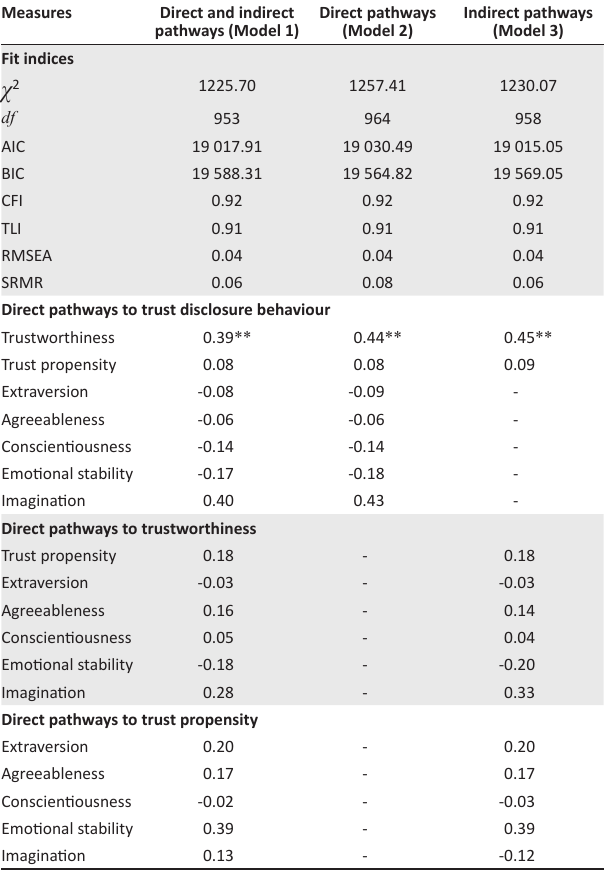
TABLE 3: Initial framework fit indices and standardised path coefficients. Measures